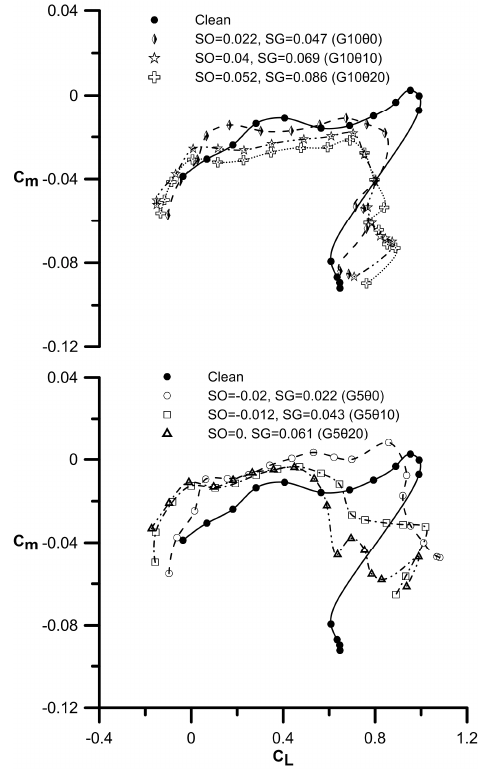
Figure 6. Effect of slat gap and angle on pitching moment coefficient.